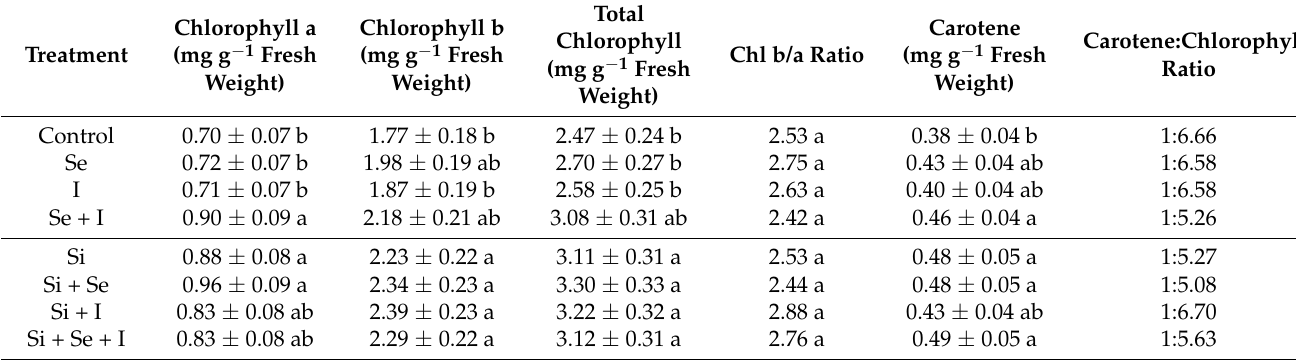
Table 2. Photosynthetic pigments in chervil plants under Se, I and Si